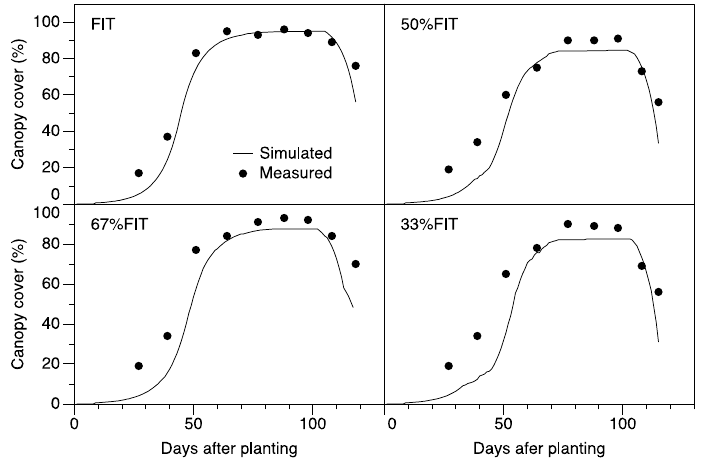
Figure 2. Simulated and measured canopy cover for the different irrigation treatments used for AquaCrop calibration.